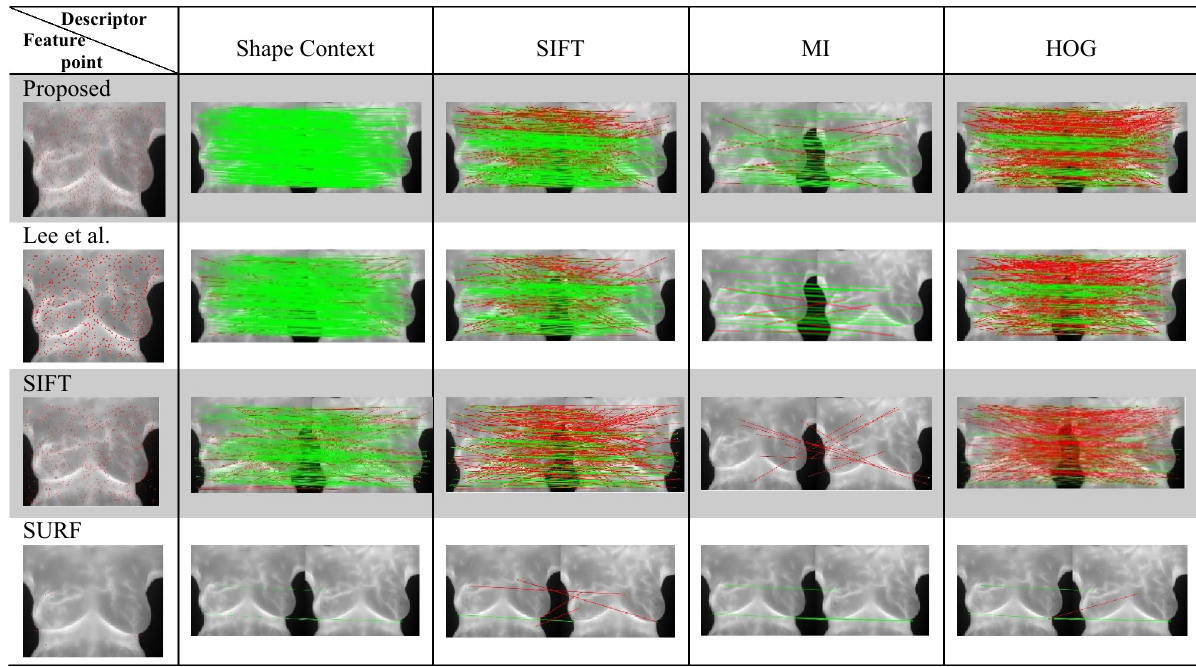
Table 2. Visualize the comparison of matching result through different combinations of feature points and